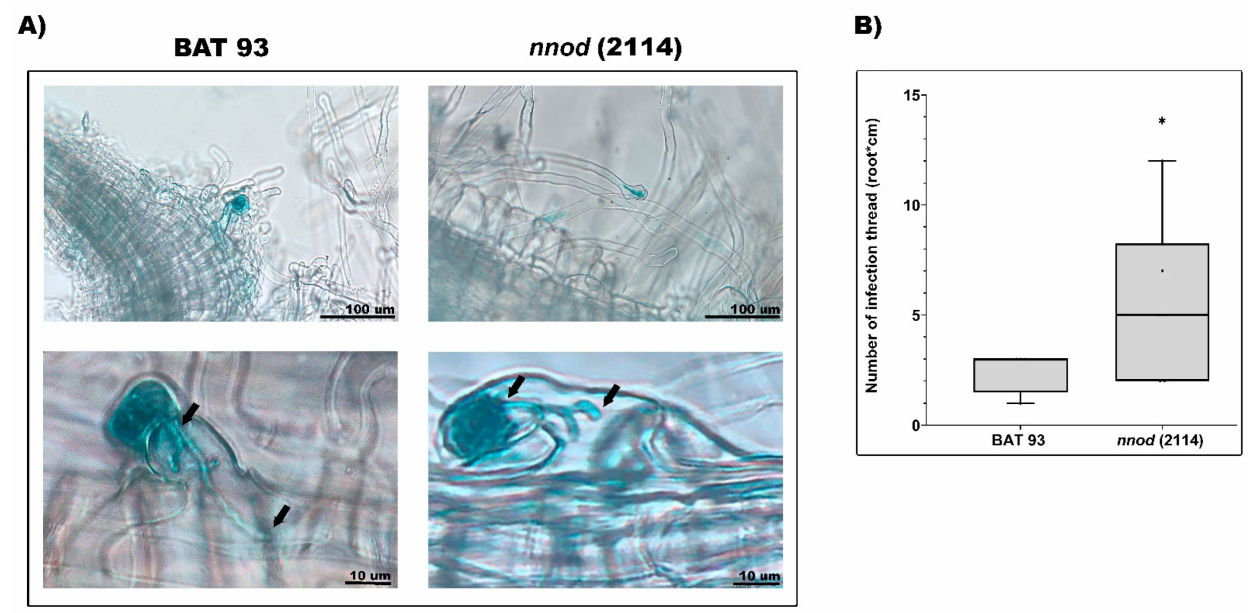
Figure 6. Infection phenotype of nnod (2114) mutant inoculated with R. etli CE3/pGUS: formation and development of infection threads (ITs). ( A ) Microscopic observations of the ITs formed in BAT 93 and in the nnod (2114) mutant, visualized after GUS staining. Arrows point to progression of an IT in the WT genotype (left) and abortion of IT development in the nnod (2114) mutant (right). ( B ) Quantification of ITs in 5 root segments (1 cm) of WT and nnod (2114)-inoculated roots. In box plots, horizontal boxes represent the first and third quartiles, while the outside whiskers represent the minimum and maximal values. (*) Significant difference of IT number between WT and nnod (2114)- inoculated roots ( p ≤ 0.1, Student’s t